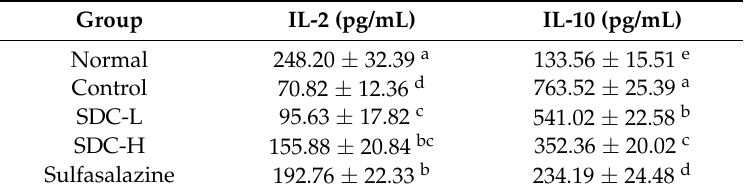
Table 12. Serum cytokine levels of interleukin-2 (IL-2) and interleukin-10 (IL-10) in mice.